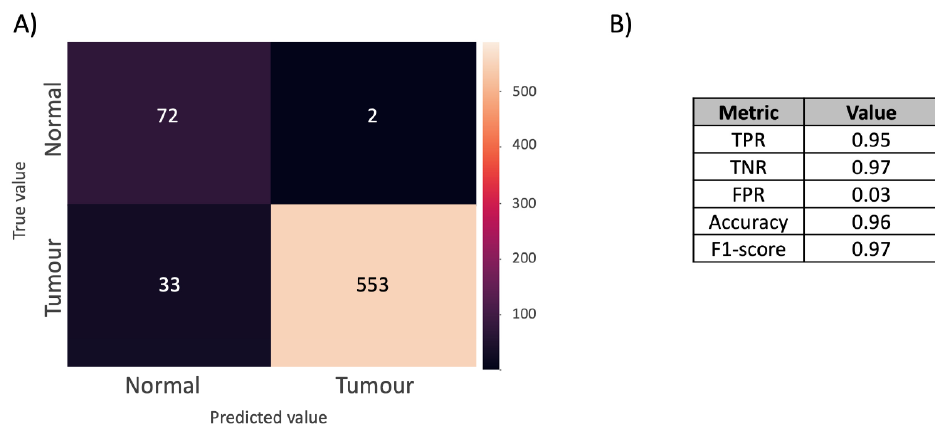
Figure 7. ( A ) Confusion matrix of the final MSI LR classification model based on only significant features. The model is produced by the cross validation of normal and tumour breast cores, comparing the predictive label ( x -axis) against the true label ( y -axis). ( B ) Model performance. The table reports the true positive rate (TPR), true negative rate (TNR), false positive rate (FPR), accuracy, and F1-score.